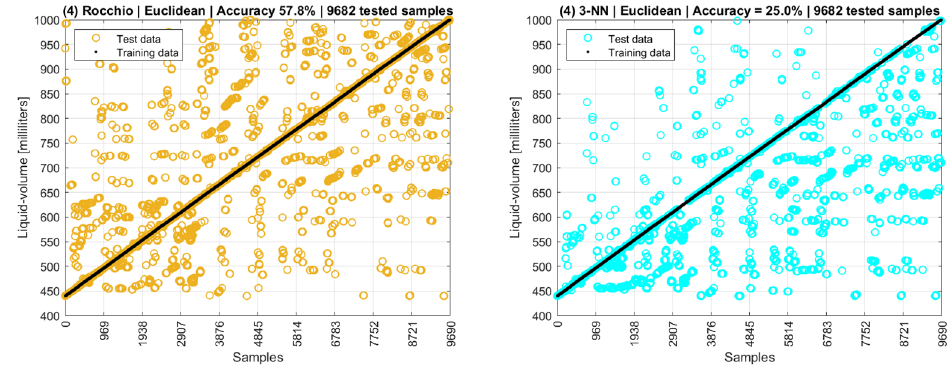
Figure 20. Rocchio and k-NN accuracies with complete datasets excluding outliers.